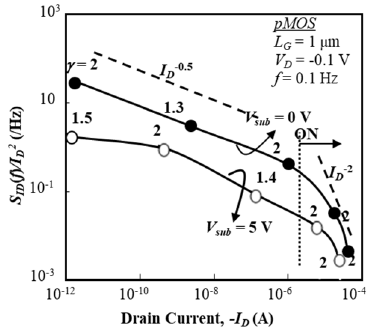
2 ( ) S f I ) of drain current as a D I D